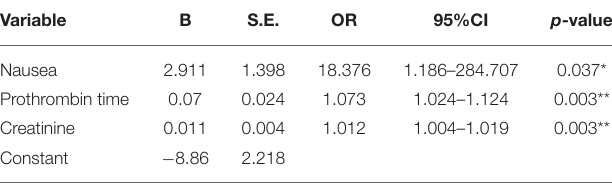
TABLE 6 | Analysis of independent risk factors for maternal death.